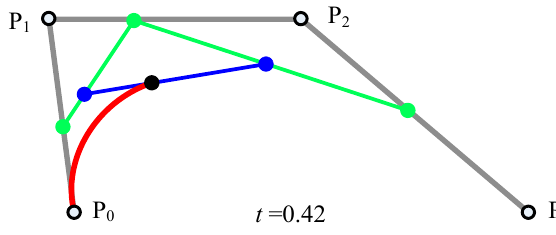
Figure 9. Schematic diagram of the cubic Bézier